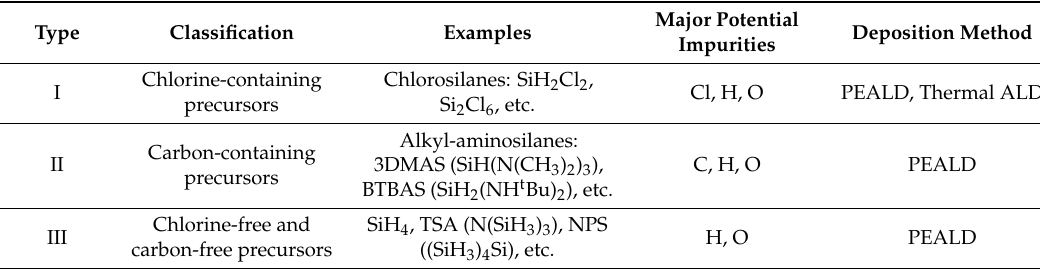
Table 3. Classification of the silicon precursors used in SiN x ALD